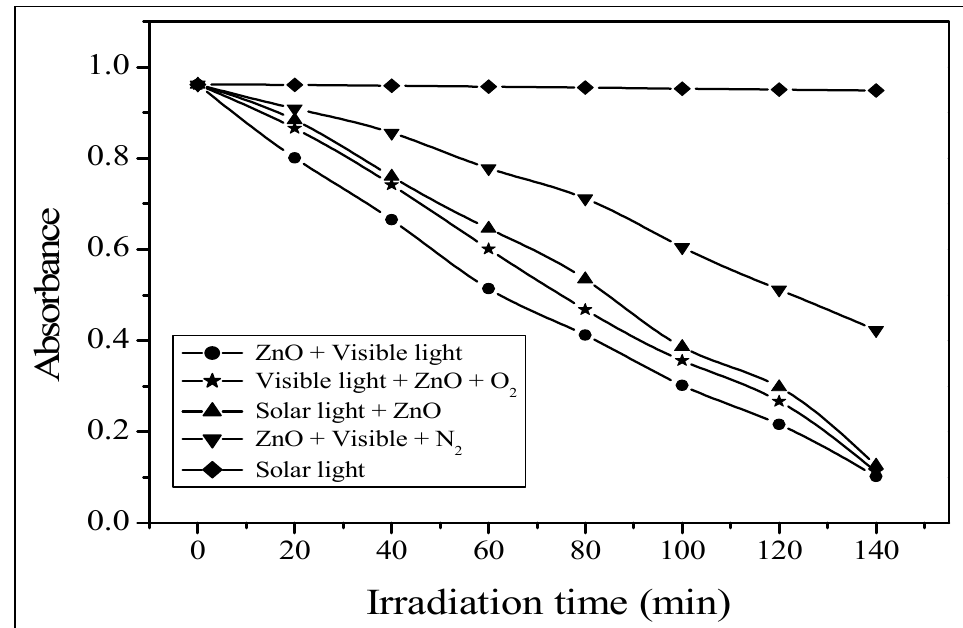
8 of 12 Figure 6. ( a ) measurement of COD removal ( b ) Measurement of CO 2 and nitrate removal.